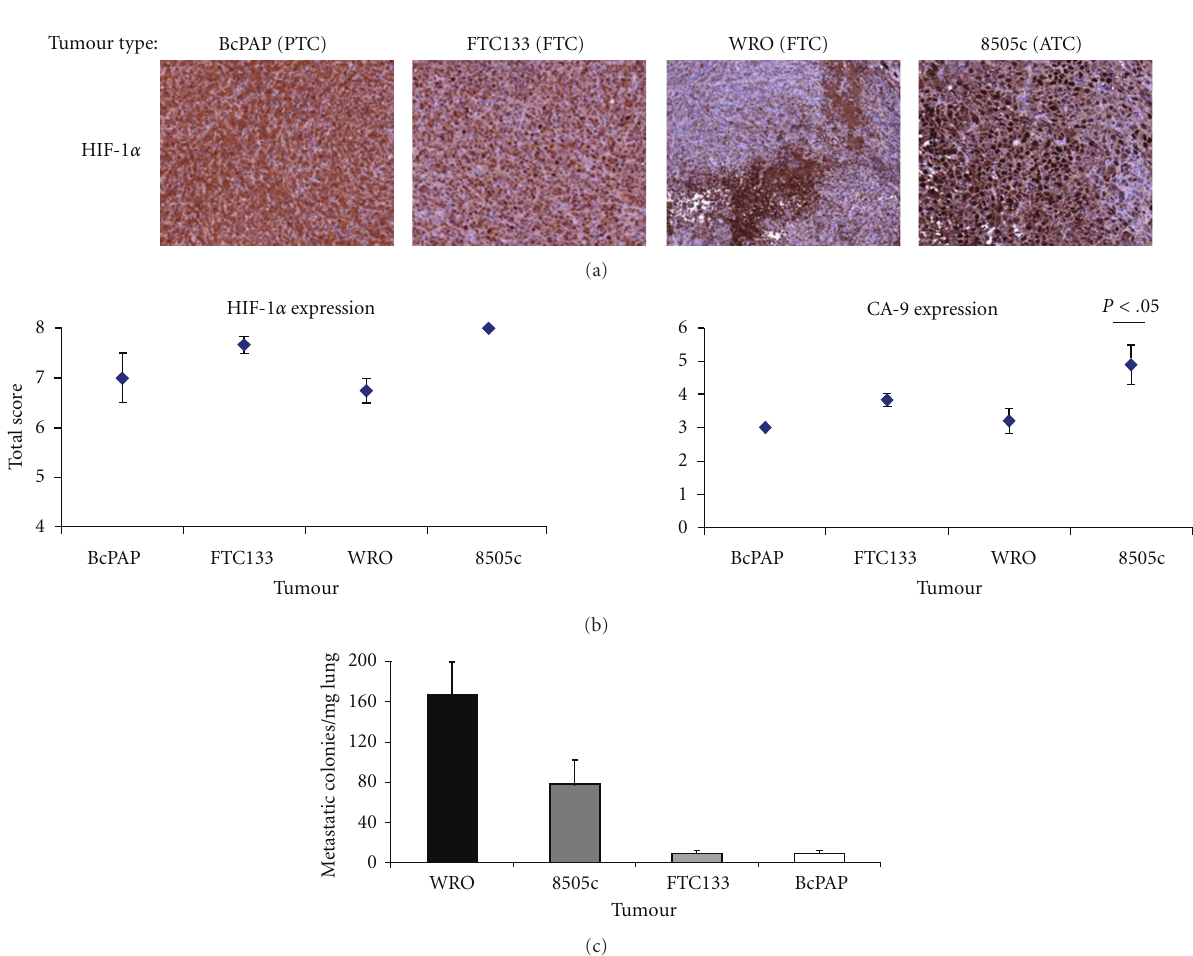
Figure 5: HIF-1 α and CA-9 protein expression and metastatic potential are highest in tumours derived from follicular (WRO)and anaplastic (8505c) cell lines. Briefly, BcPAP, FTC133, WRO and 8505c cells were implanted sub-cutaneously in female CBA nu/nu nude mice. Once tumours reached 450mm 3 , tumour tissue and fresh lung tissue were excised. Tumour sections were immuno-stained for HIF-1 α . Freshly excised lung tissue was enzymatically digested, plated out in serial dilution and left until visible colonies formed. Colonies were stained, counted and number of metastatic coloniesper mg lung tissue calculated. (For full methods, see supplementary materialsand methods which is located at doi: 10.406/2011/762905). (a) Immunohistochemical staining for HIF-1 α (brown staining). One example of HIF-1 α staining for each tumour type: BcPAP, FTC133, WRO and 8505c are displayed. (b) Semiquantitative analysis of HIF-1 α and CA-9 immunostaining quantified according to Allred et al. [109]. The total score is representative of intensity and proportion of staining. HIF-1 α was highly expressed in all tumour types with highest expression observed in the 8505c tumours. CA-9 was also expressed in all tumour types with significantly higher expression observed in 8505c tumours ( P < . 05, one way Anova, with Tukey post test). (c) The number of spontaneous metastatic colonies cultured from enzymatically digested lung tissue that was excised from mice bearing WRO, 8505c, FTC133, and BcPAP tumours. The highest number of colonies counted were from the lungs of mice bearing FTC (WRO) and ATC (8505c) tumours. Data are representative of the mean ± S.D. of 5 independent mice for each tumour